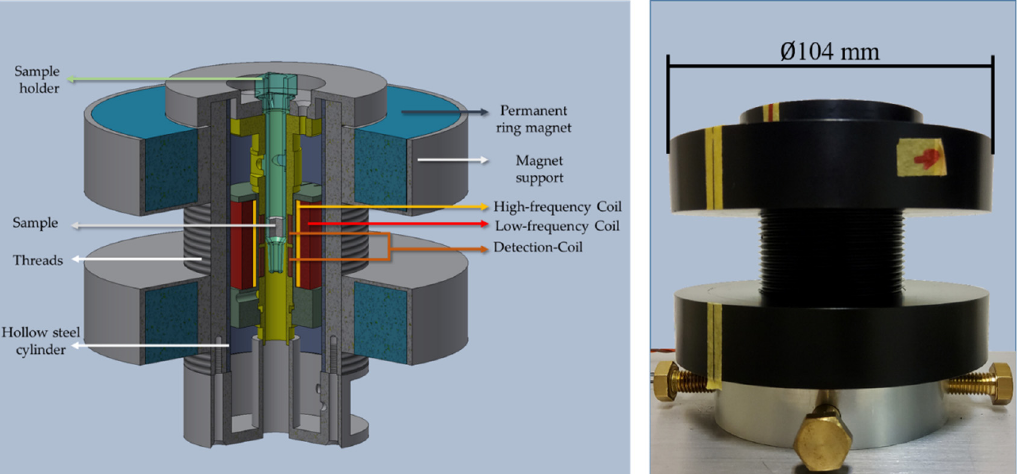
Figure 2. ( Left ) Schematic representation of the PMOM measurement head, the individual parts are labelled. ( Right ) The picture of the PMOM measurement head, which is held inside a place holder and fastened using three hexagonal